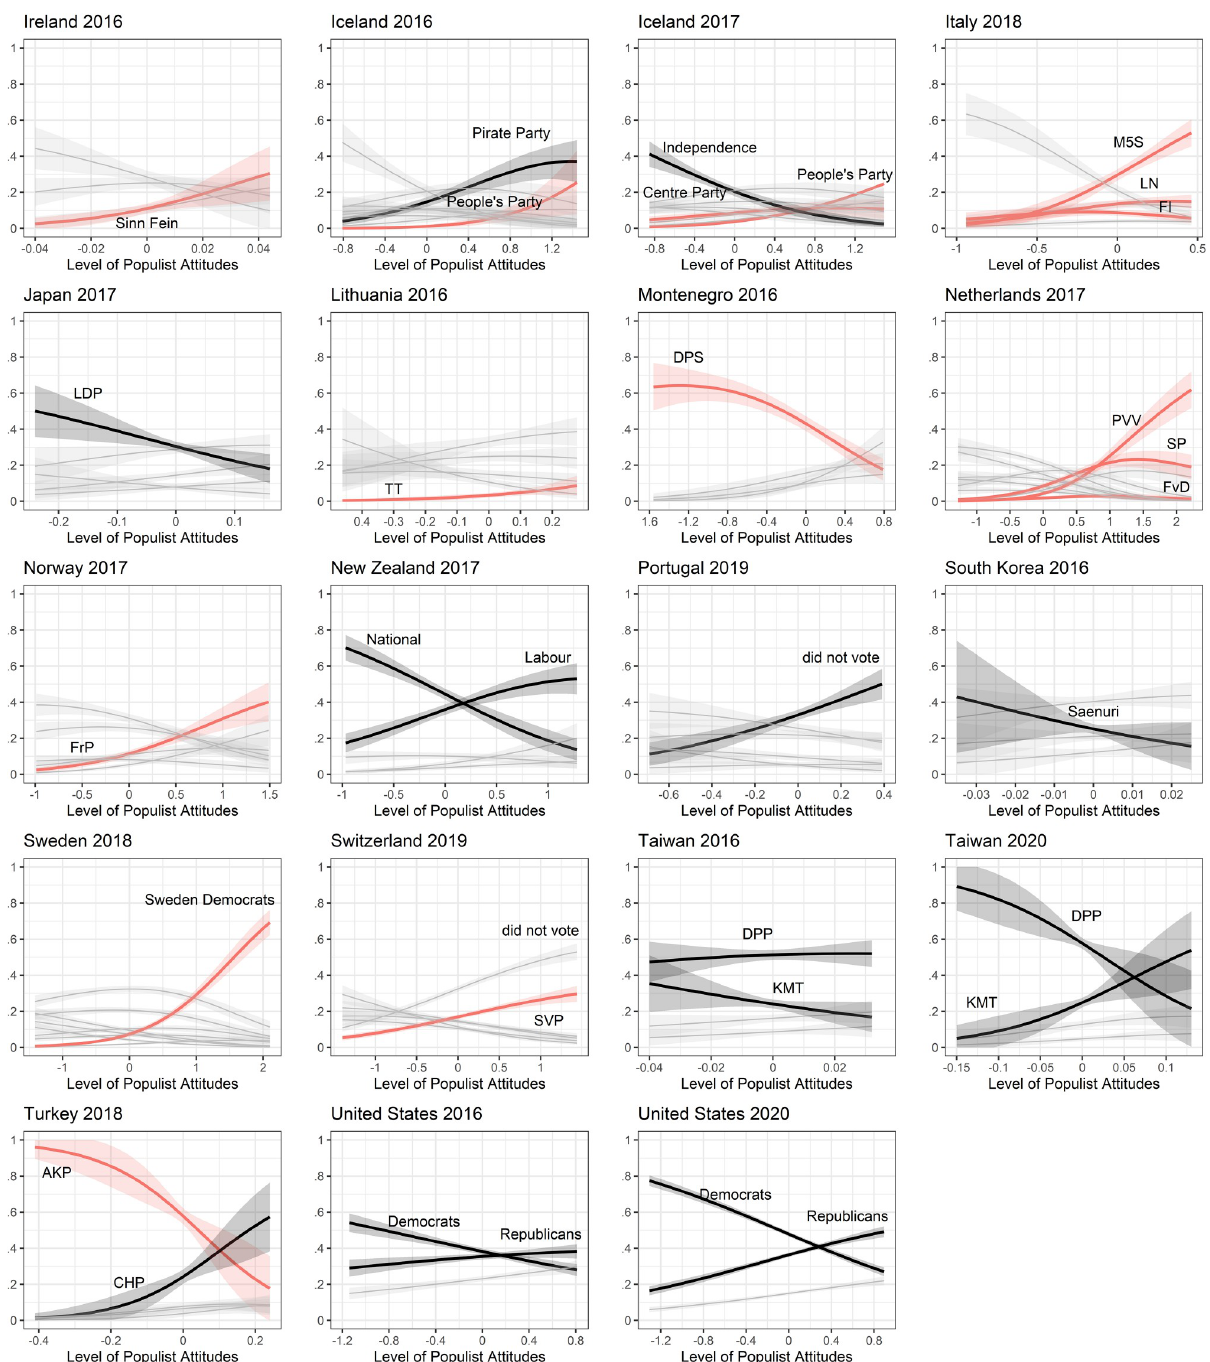
Fig 3. Predictions of populist vote across countries II. Predictions of vote choice are based on multinomial structural equation models with 95% confidence intervals.